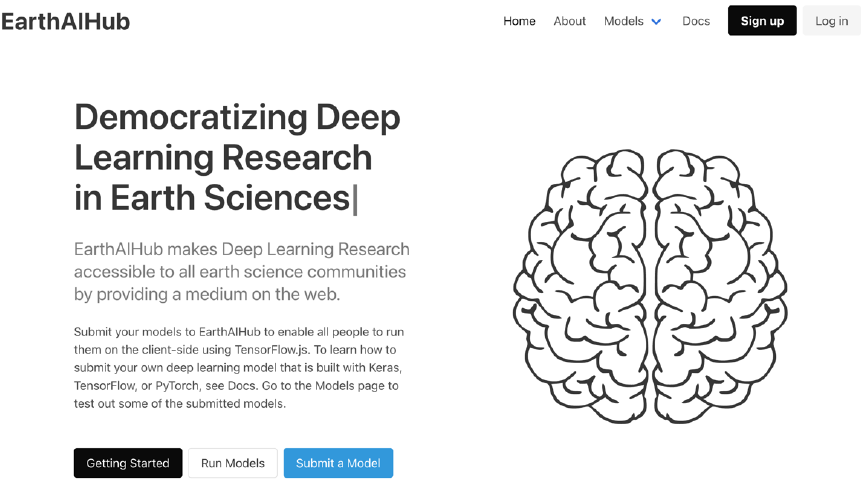
Figure 1. Landing page of EarthAIHub deep learning platform.